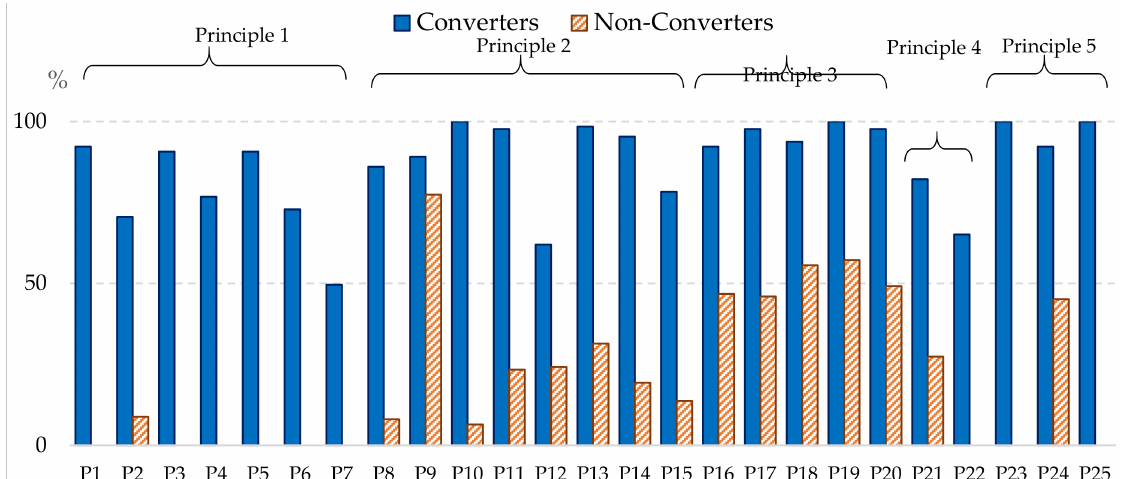
Figure 2. Percentage of households implementing each of the 25 specific HPRS practices in north- ern Thailand.